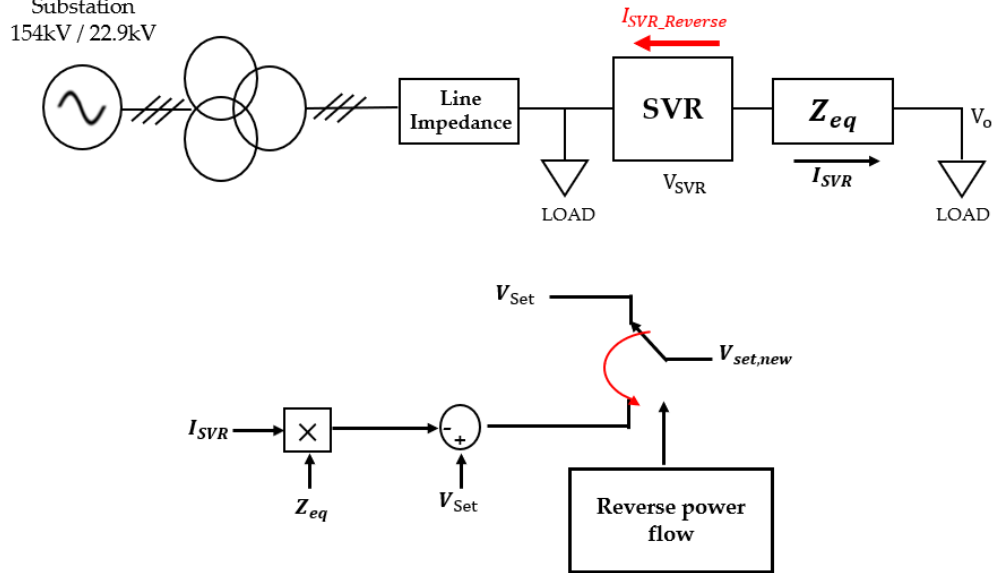
Figure 11. 𝑉 𝑠𝑒𝑡,𝑛𝑒𝑤 Controller for the proposed algorithm Figure 11. V set , new Controller for the proposed